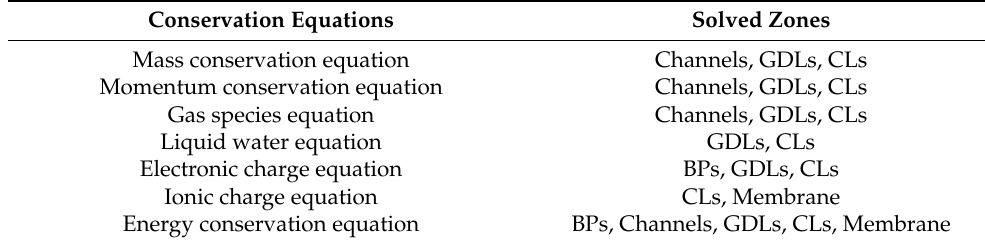
Table 3. The solving zones of the governing equations.